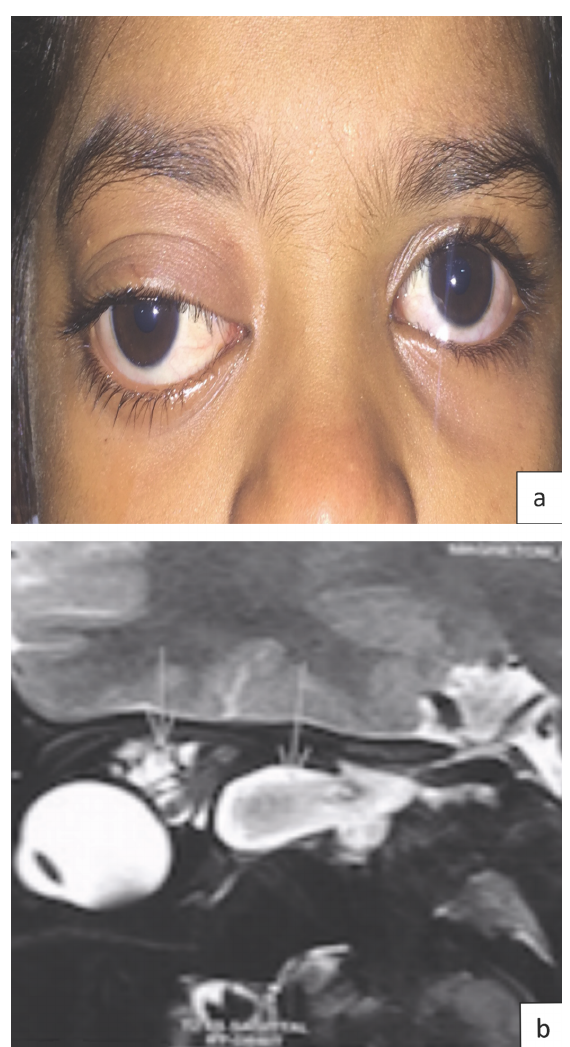
Figure 1: a) Clinical picture of the patient with down and out proptosis; b) MRI orbit sagittal view showing cystic component of lymphangioma above and below the optic